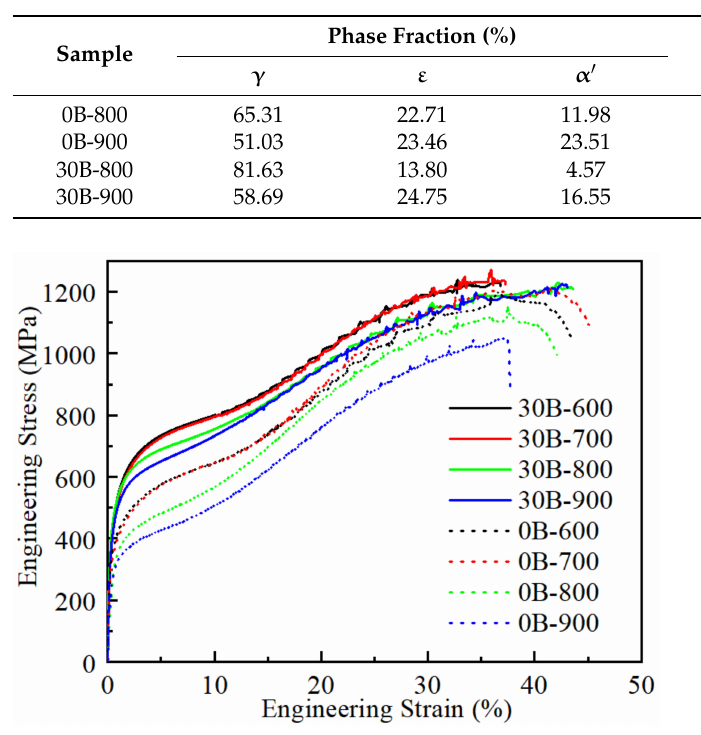
Figure 4. Engineering stress-strain curves of the annealed samples. Table 4. Mechanical properties of the annealed